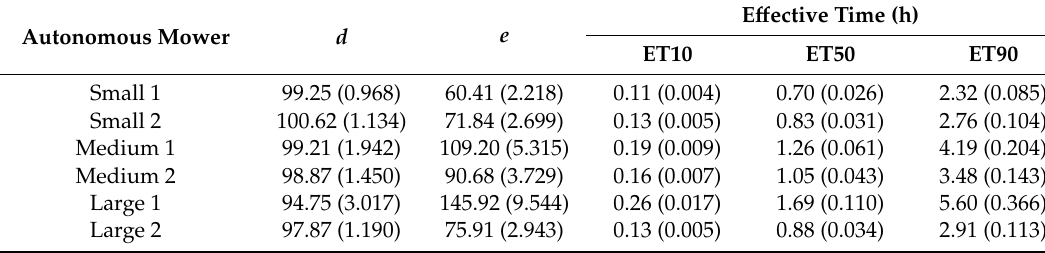
Table 5. Parameters of the non-linear asymptotic regressions (Equation (1)) and e ff ective time of the autonomous mowers estimated from the two-stage meta-analysis dose–response model on Site B. Autonomous